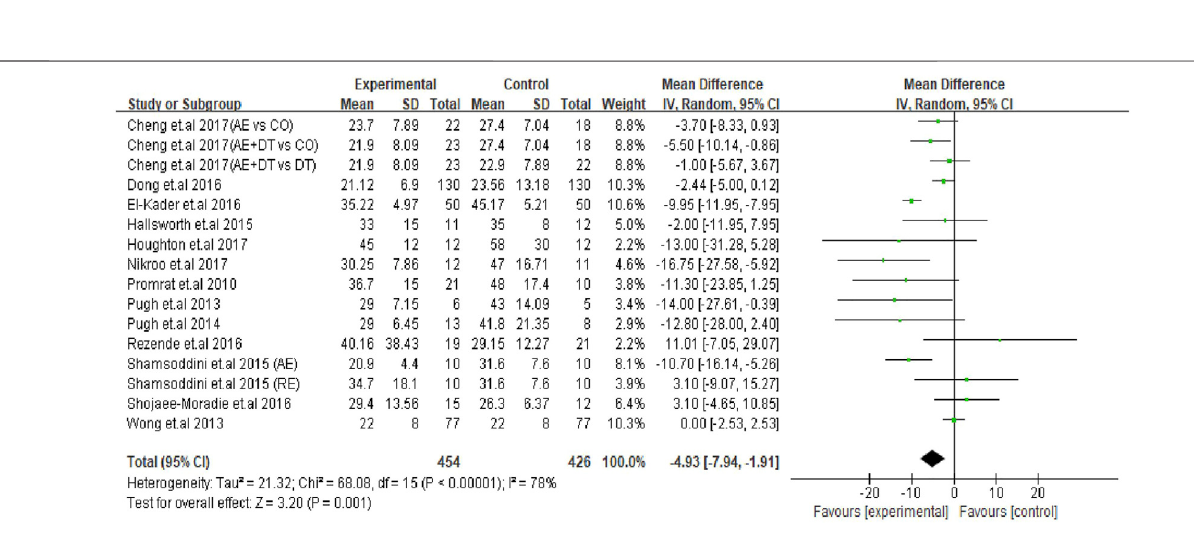
Frontiers in Physiology |